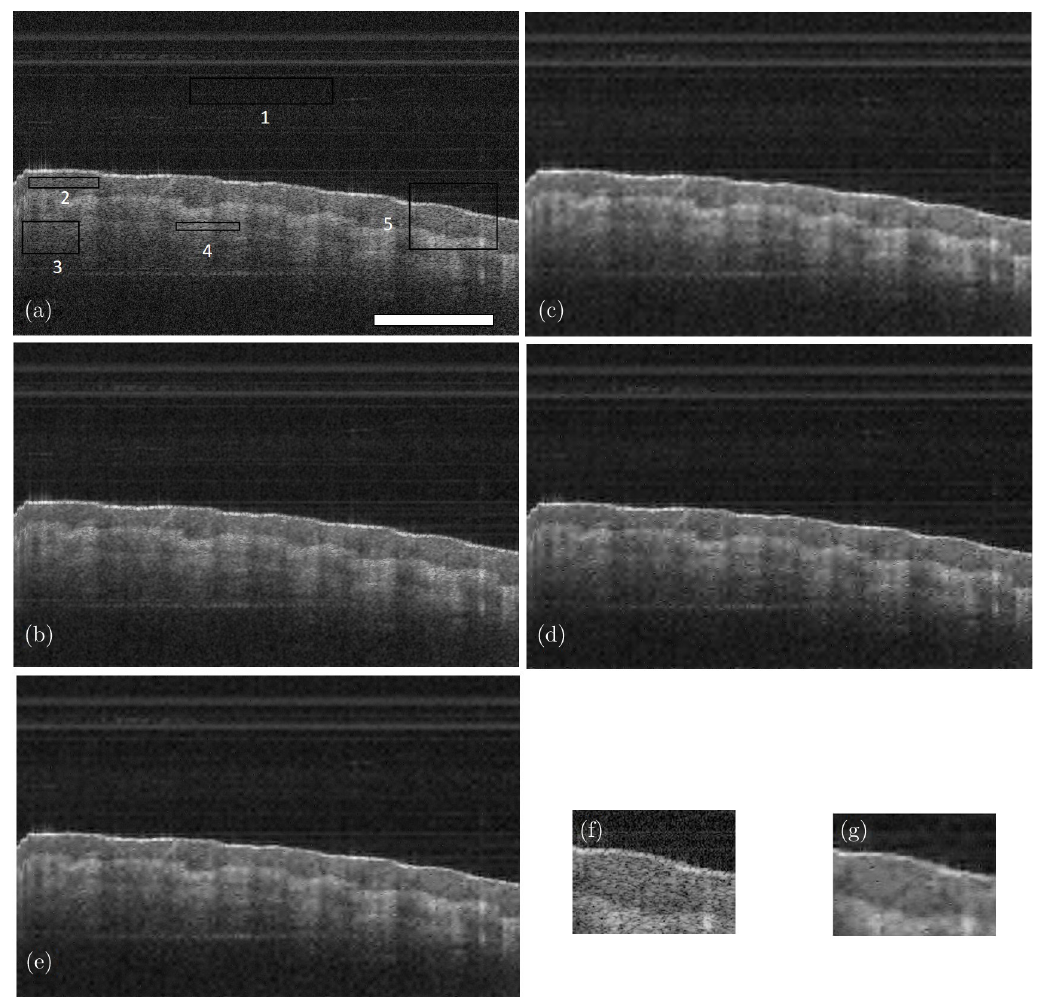
Fig. 6. Comparison of di®erent de-noising methods for an OCT ¯nger skin image. (a) Noisy image with one background region and four ROIs marked in black, (b) image after 3*3 Wiener ¯ler, (c) image after soft-threshold wavelet ¯lter, (d) image after hard- threshold wavelet ¯lter, (e) image after improved threshold wavelet ¯lter, (f) zooming up of the 5th ROI from Fig. 6(a), (g) zooming up of the same region from Fig. 6(e). Scale bar in Fig. 6(a) is 500 (cid:5)